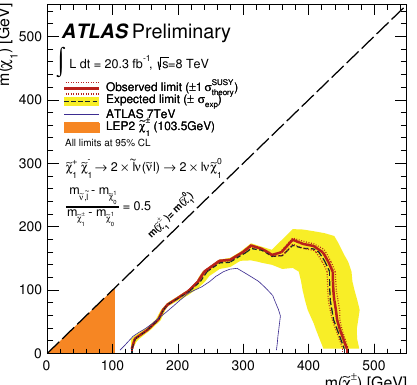
Figure 11: 95% CL exclusion limits for both right- and left handed (mass degenerate) selec- tron and smuon production in the m A common value for left and right-handed slep- ton masses between 90 GeV and 320 GeV is excluded at 95% confidence level for a massless neutralino. [10]